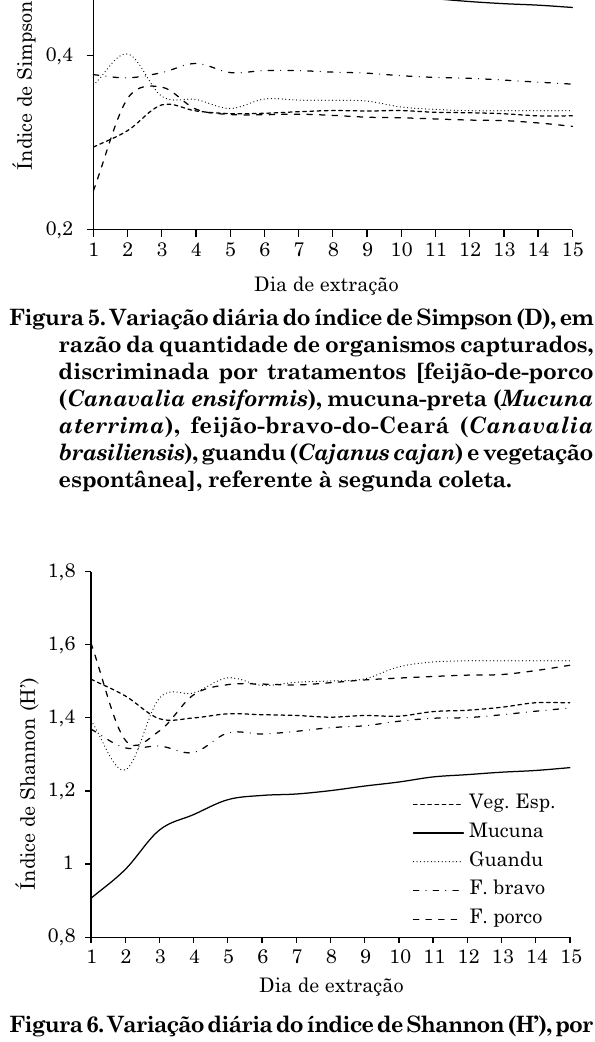
Figura 4. Variação diária do índice de Margalef (I), por causa da quantidade de organismos capturados, discriminada por época de avaliação: em outubro, um dia antes do plantio das leguminosas; e, em março, por ocasião do corte da parte aérea das plantas.